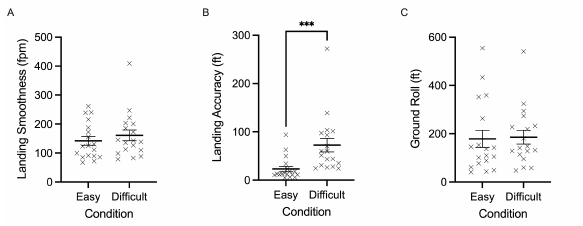
Figure 3. Individual data points and their respective group means for landing smoothness (fpm) (A), landing accuracy (ft) (B), and ground roll (ft) (C) are demonstrated for easy and difficult con- ditions. Error bars represent SEM. * p ≤ 0.05, ** p ≤ 0.01, *** p ≤ 0.001, **** p ≤ 0.0001.